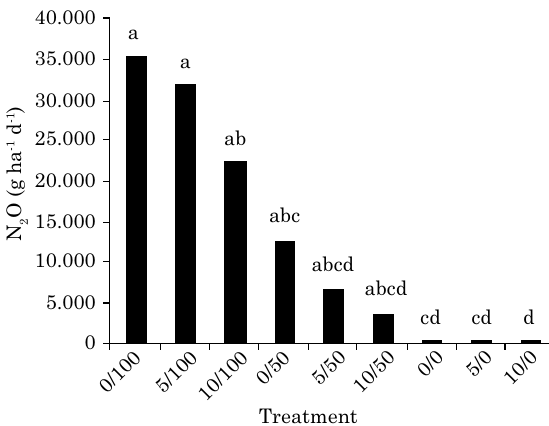
Figure 2. Acummulated emissions of N 2 O from soil in pots, under different amounts of rice straw (0, 5 and 10 Mg ha -1 ) and NO − 3 -N rates (0, 50 and 100 mg kg -1 ), during 12 days of flooding. Means with the same letters do not differ significantly at 5 % by the Kruskal-Wallis test of means comparison.